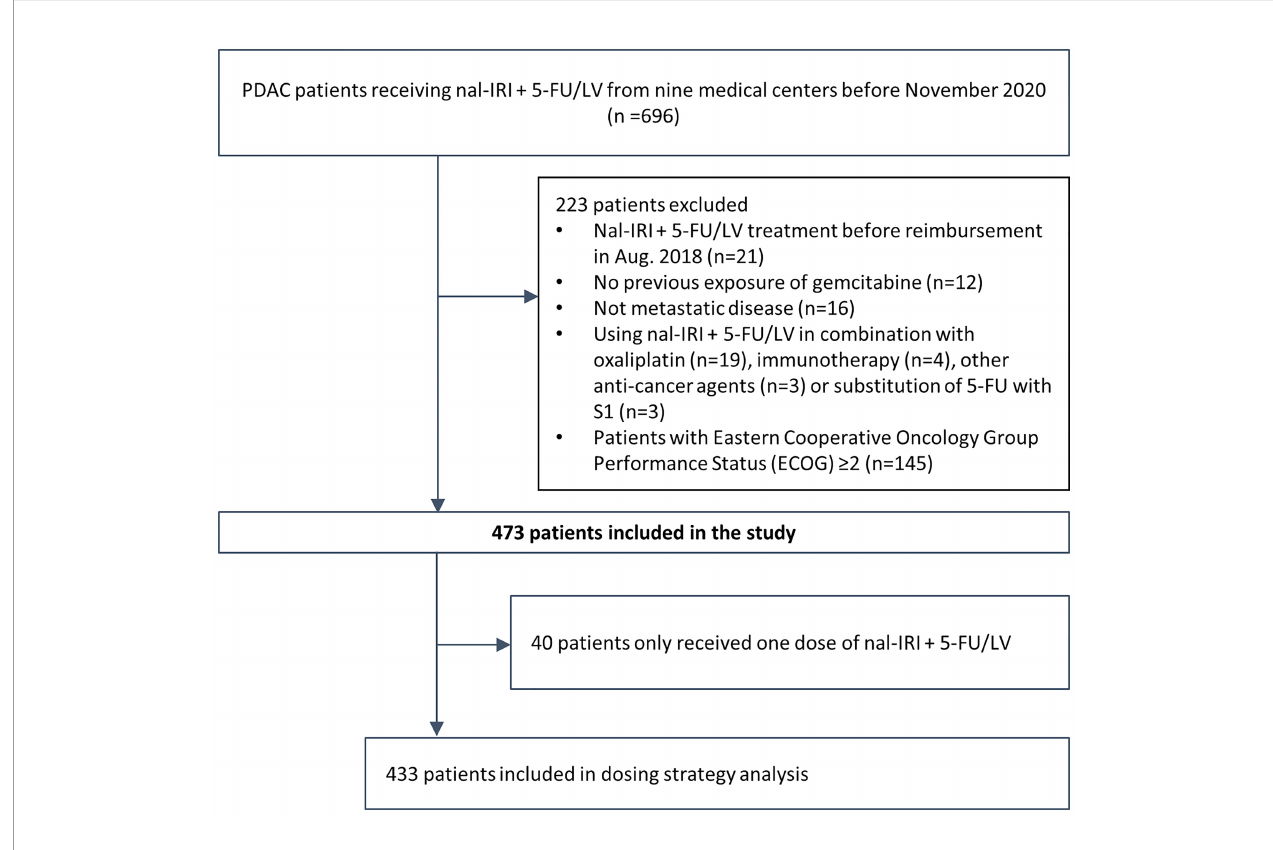
FIGURE 1 | Flowchart of study